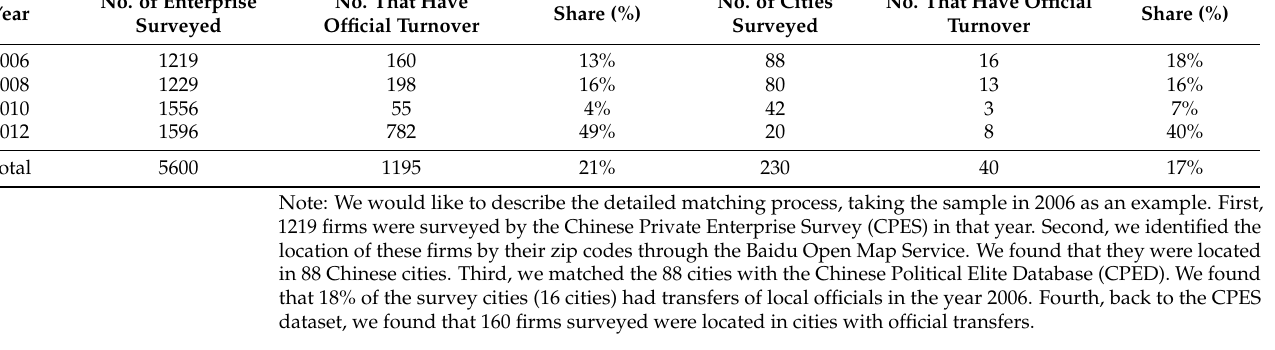
Table A2. The differences in environmental effects between officials transferred from different places and transferred from the same city through